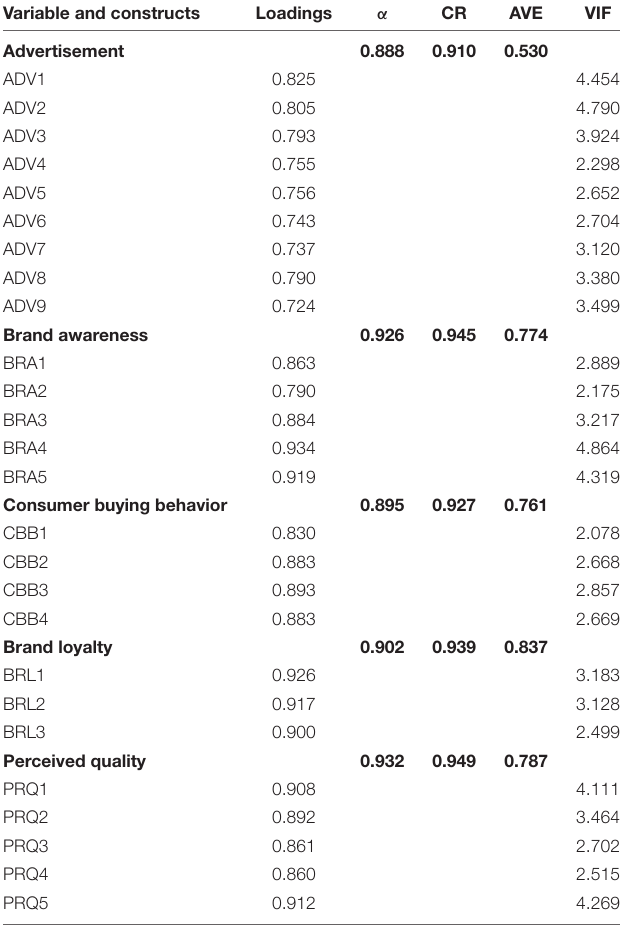
acceptable and above the threshold value (Sarstedt and Cheah, 2019). Moreover, construct validity was analyzed using average variance extracted AVE. The values of AVE were presented in Table 2 . The values of AVE for advertisement were